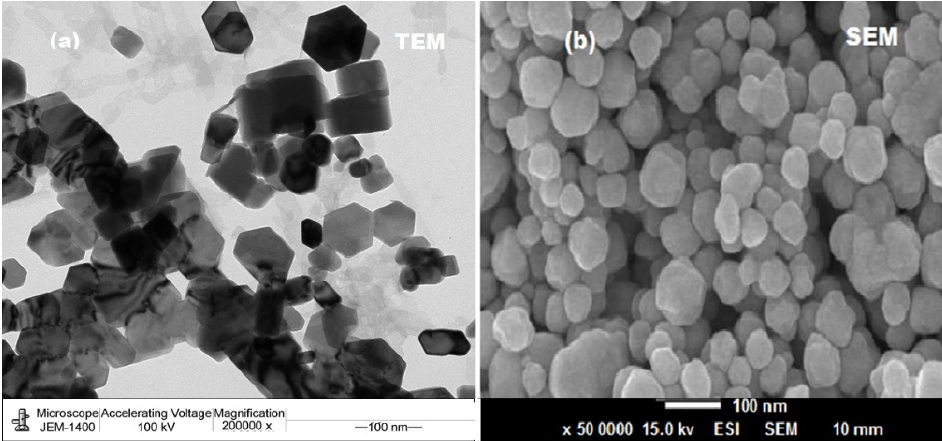
Figure 5. ( a ) TEM and ( b ) SEM images of ZnONPs synthesized using oat biomass.